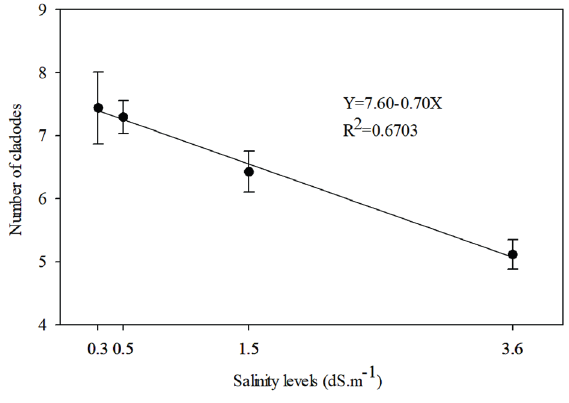
Figure 4 - Number of cladodes from cactus pear cv. Miúda according to the salinity levels. Error bars represent the standard error of the mean.